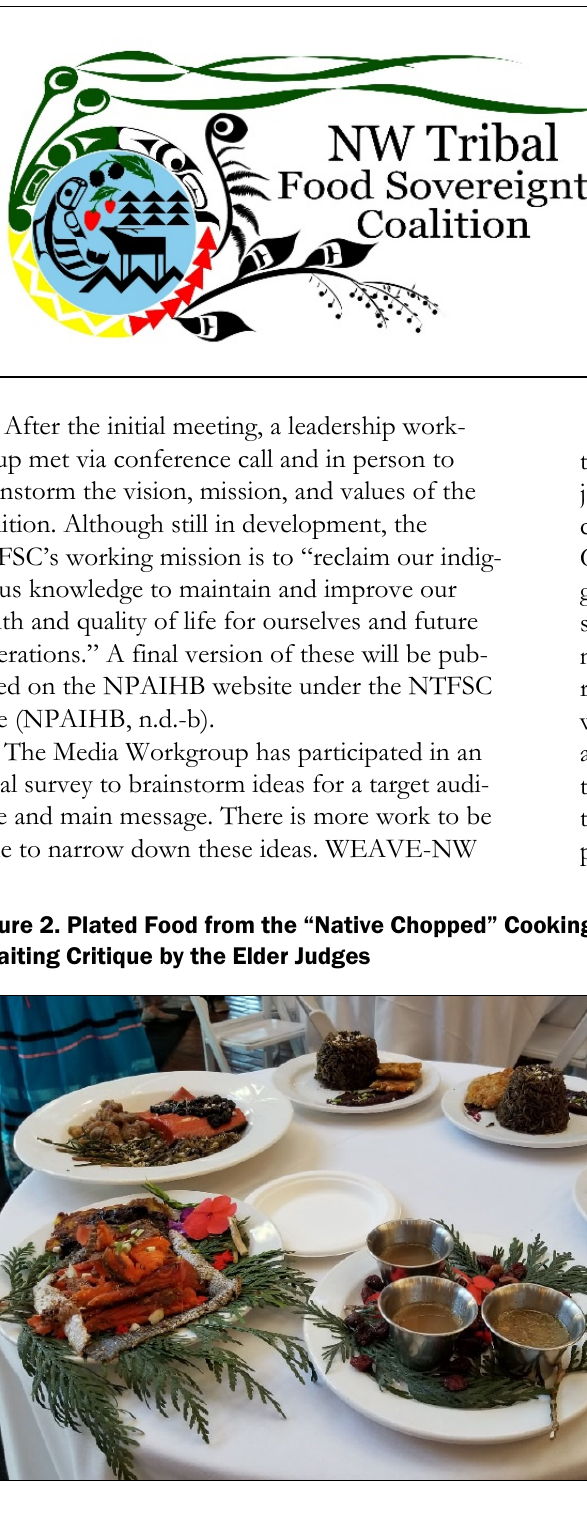
Figure 1. Northwest Tribal Food Sovereignty Coalition Logo Representing the Diversity of Plant and Wildlife of the Region